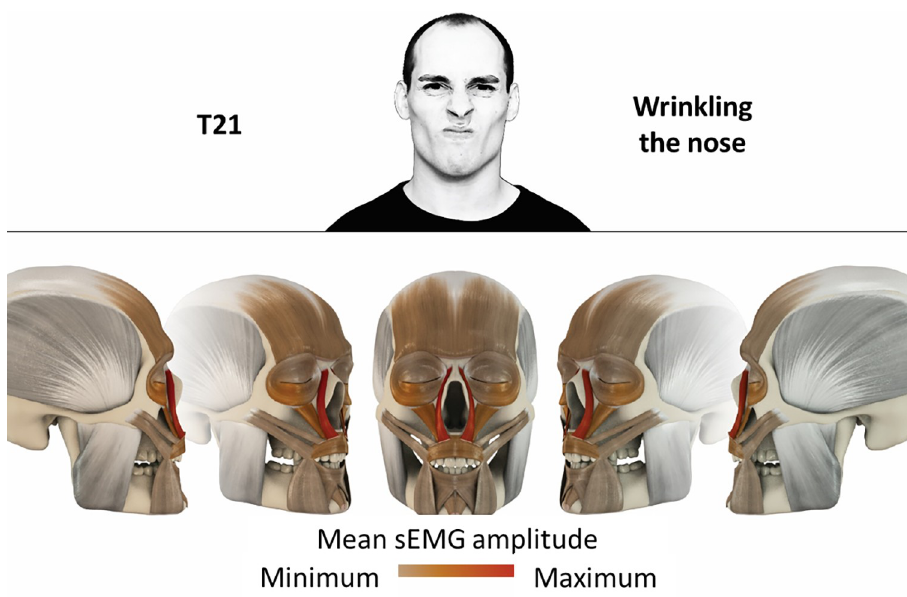
Fig 22. Color-coded facial muscle activation pattern of task T21. Wrinkling the nose. Animation by Jonas Laustro¨er.